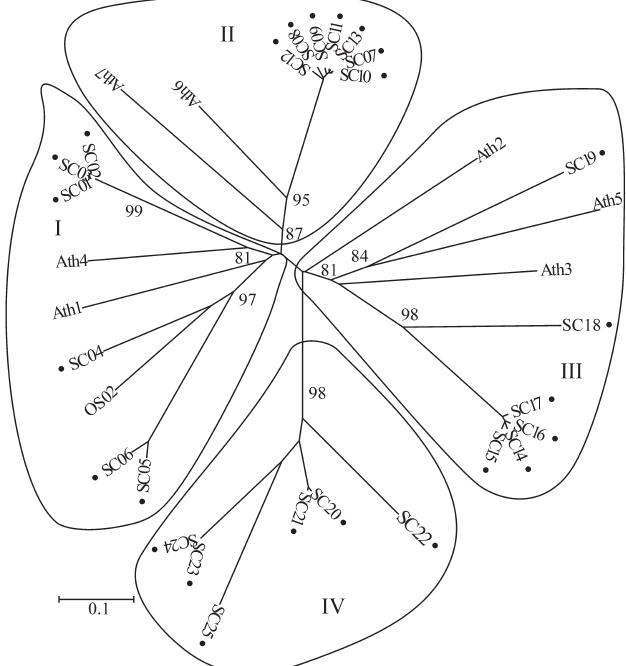
Figure 2 - Phytocystatin phylogenetic tree. The tree was constructed using MEGA software with the following parameters: p-distance, neighbor-joining, pair-wise deletion and internal branch test with 5000 replications. The analysis was performed based on the MAP alignment of 25 sugarcane clusters, seven A. thaliana phytocystatins (Ath1 to Ath7) and rice phytocystatin-II (OS 02). Four major groups with different phytocystatin forms were identified. The values obtained from the internal branch replication (80%) are indicated in the main branch